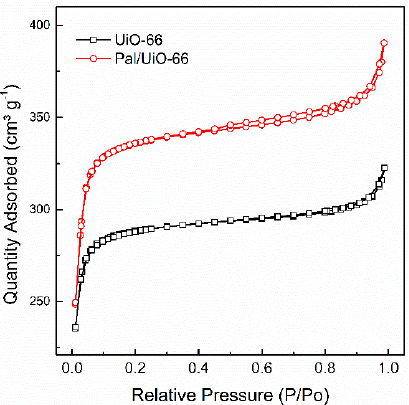
Figure 4. N 2 adsorption–desorption isotherms for pure UiO-66 and Pal/UiO-66 composite.